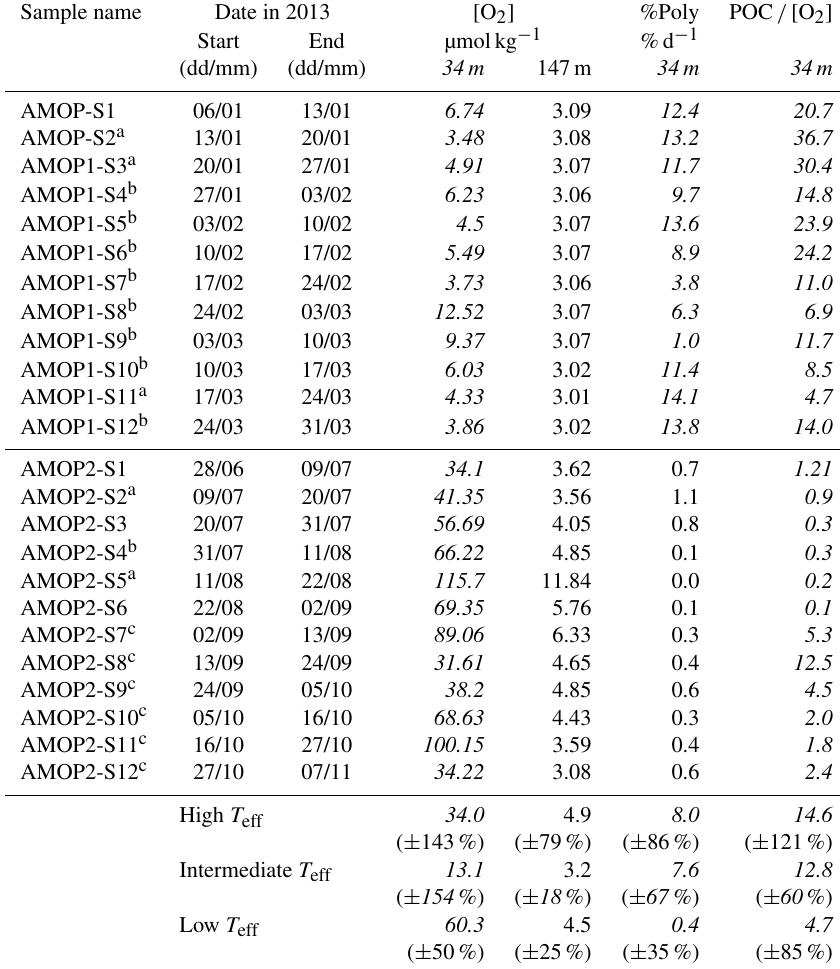
Table 2. Oxygen concentration in the upper and bottom OMZ layer, proportion of Polychaetes number of individuals, and POC flux / O 2 con- centration ratios. O 2 concentration corresponds to the oxygen concentration averaged on the sampling acquisition periods: [ O 2 ] 7days_15min for AMOP summer (denoted AMOP1) and [ O 2 ] 11days_15min for AMOP winter–spring (denoted AMOP2). %Poly corresponds to the percentage of number of individuals of Polychaetes relative to all collected swimmers, per day. The POC flux / O 2 concentration corresponds to the ratio of both weekly quantities (POC flux collected in the trap and [ O 2 ] 1week_15min determined from the O 2 sensor). Italic values correspond to the [O 2 ], %Poly and POC flux / O 2 concentration at the upper trap, and non-italic values at the lower trap. In the last lines of the table, [O 2 ], %Poly and POC flux / [O 2 ] averaged values for low, intermediate and high T eff ranges, respectively, with the relative standard deviation among samples ( ± SD%). %Poly is determined from a significant number of Polychaetes individuals collected per sample (4607 on average, between 50 and 31099). Note that Polychaetes and copepods represent 97% of all the reported